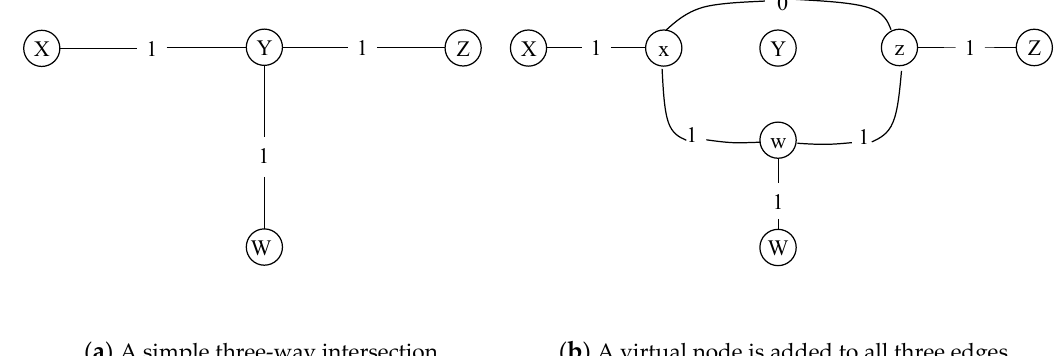
Figure 4. Schematic diagram of turning relationship transformation method.